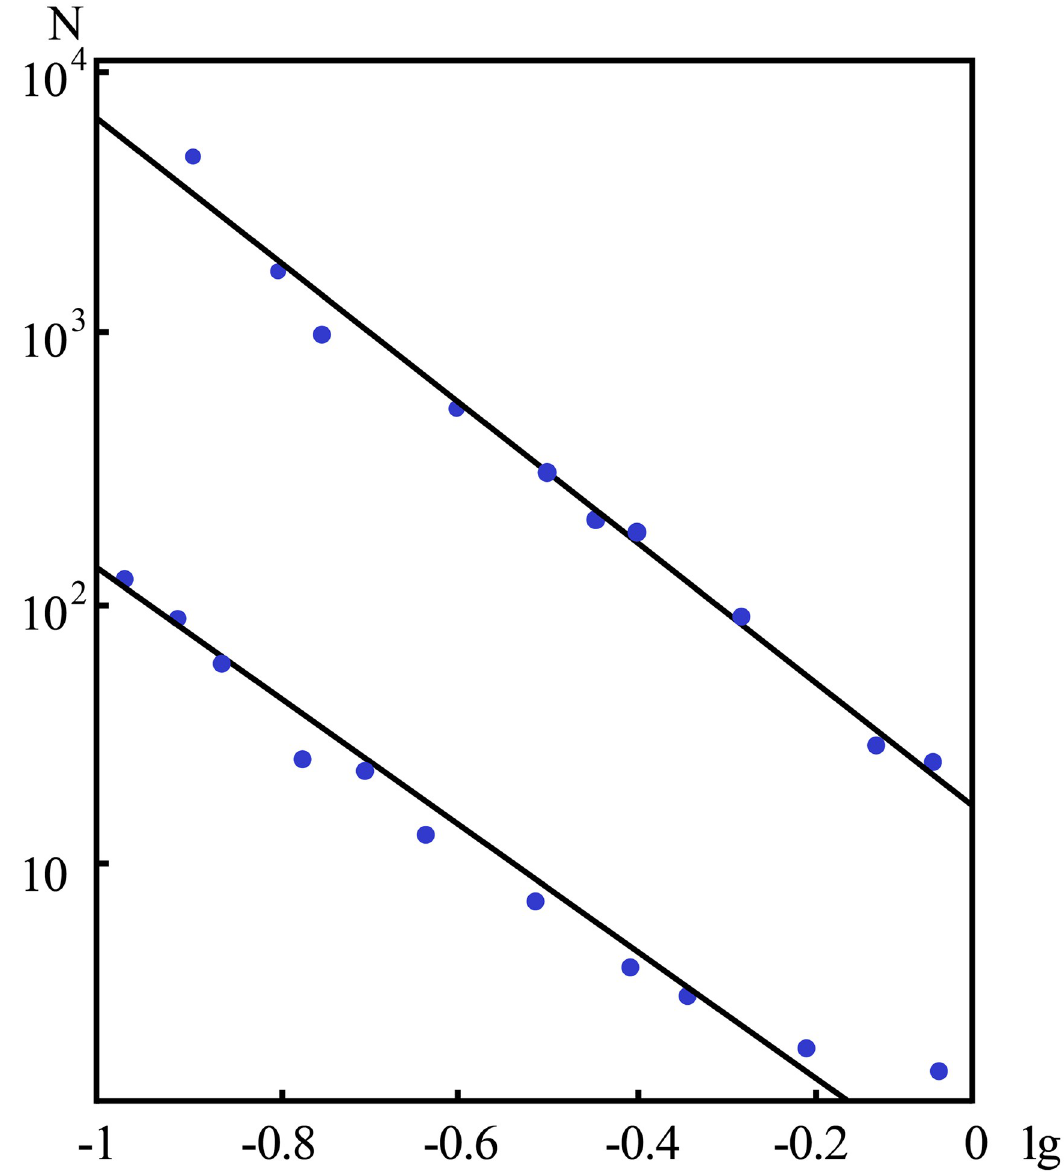
Fig 9. Characteristics of the total AE number N near the critical stress (representing the experimental